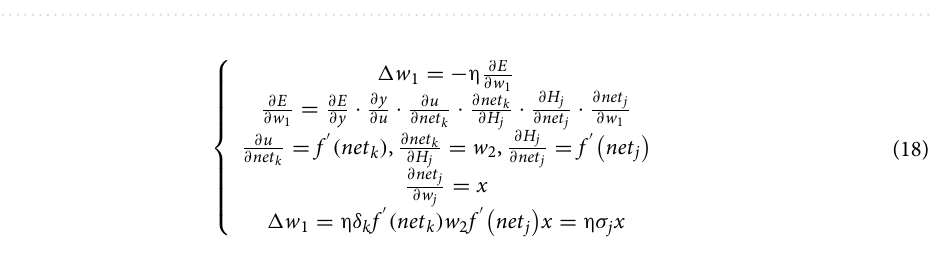
Figure 11. Structure of a chromosome for the proposed ANN